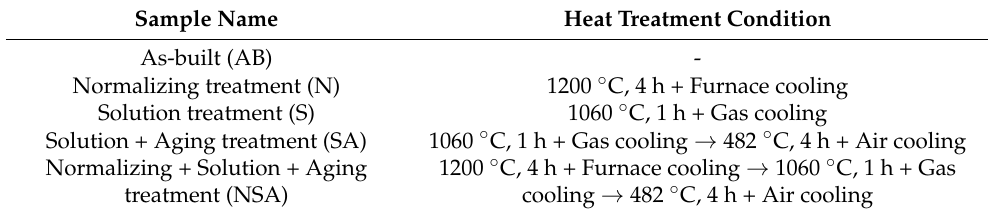
Table 2. Heat treatment condition of sample using fabricated L-PBF.